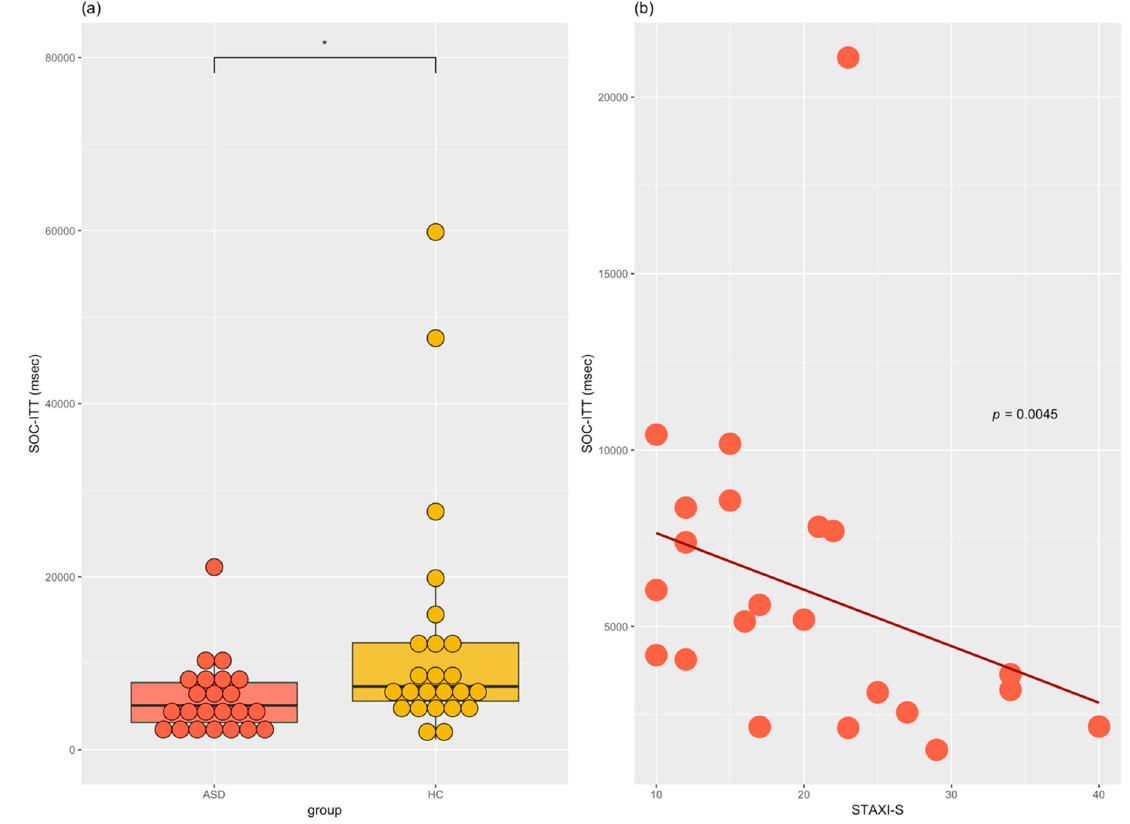
Figure 1. Executive functioning of ASD and HC. ( a ) Group differences for SOC-ITT; ( b ) Spearman’s correlation for STAXI-S and SOC-ITT in the ASD group; * p < 0.05; ASD = acute stress disorder; HC = healthy control; STAXI-S = State-Trait Anger Expression Inventory-state; SOC-ITT = Stockings of Cambridge-mean initial thinking time on five moves (msec).